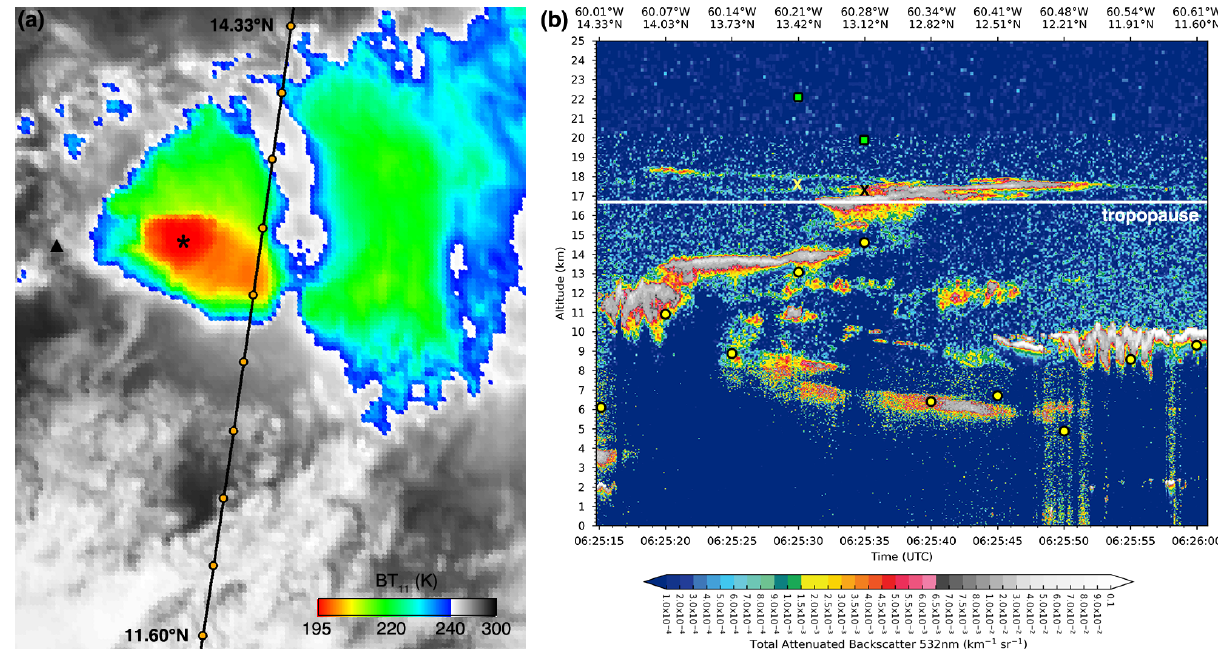
Figure A1. (a) GOES-16 BT 11 of the plume on 10 April 2021 at 06:30UTC. The black line is the CALIPSO orbit track with 10 specific points marked by orange dots. The black triangle is the volcano and the black star is the coldest plume pixel. (b) CALIOP total attenuated backscatter at 532nm. The white line is the tropopause, and the circles, crosses, and squares respectively depict the minimum, mean, and maximum plume heights corresponding to the BT 11 at the 10 orange track points in panel (a)